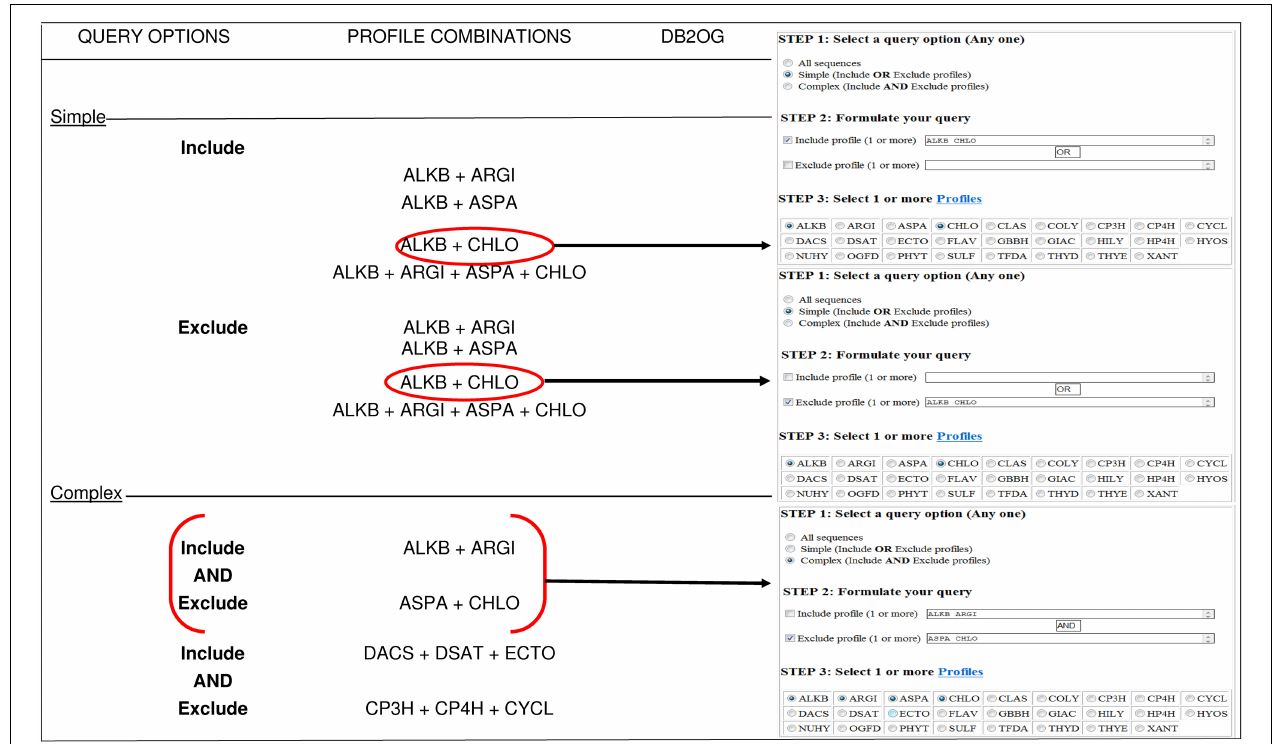
FIGURE 1 | Profile based search of sequences in DB2OG. Users may query the database for putative 2-OG dependent sequences using one or more of the pre-defined HMM profiles ( N = 26). A structured query of this nature (simple or complex), without an inclusion score will list all sequences with